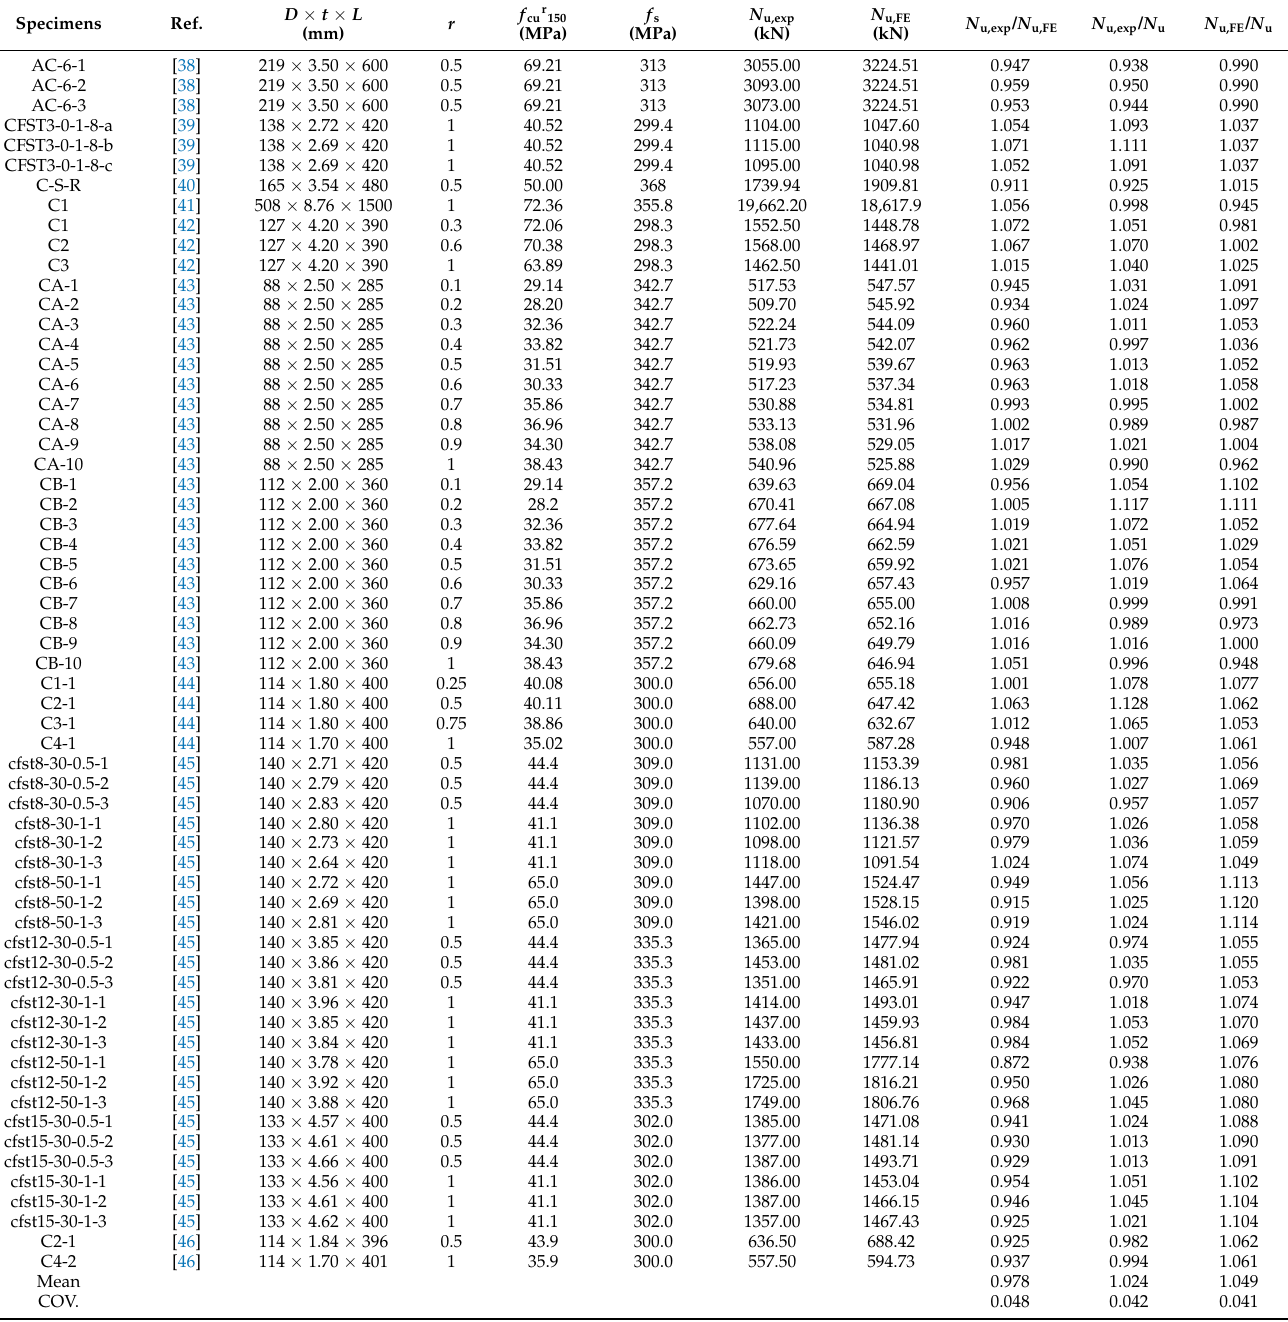
Table 2. Comparison of loading bearing capacity obtained from experimental and predicted